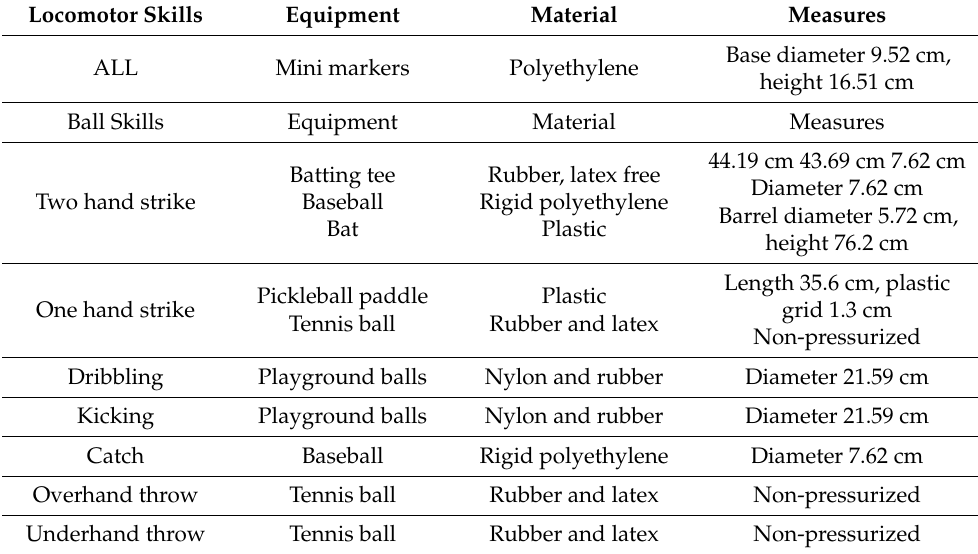
Table 4. Equipment needed for the TGMD-3